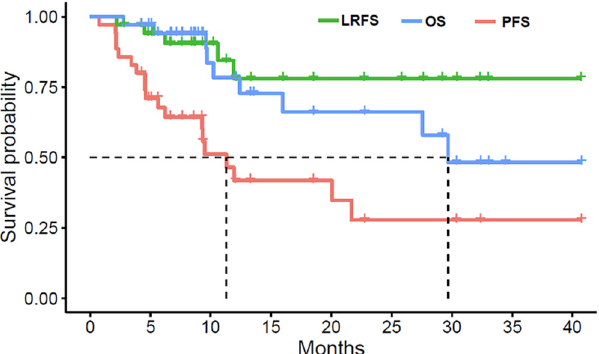
Figure 1. Local relapse-free survival (LRFS), progression-free survival rate (PFS), and overall survival rate (OS) for all patients.